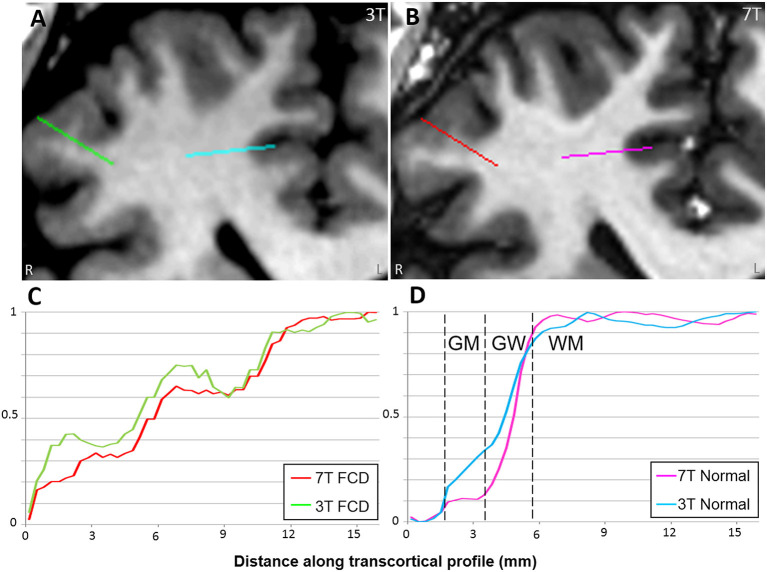
Comparison of MRI signal intensity plots along transcortical profiles obtained from FCD and normal cortex in a patient with histopathologically confirmed FCD type IIb. 3T T1w MPRAGE (A) and 7T T1w MP2RAGE (B) were used for the comparison. Signals are plotted across the transcortical profiles shown on the MRI (starting from GM and ending at WM). Zero was set as the mean signal from CSF. Signals were normalized with their min and max values. In the normal cortex (D), GM, WM, and gray-white transition (GW) can be clearly distinguished from the 7T signal plot. In the FCD cortex (C), such distinction is absent due to GW blurring.